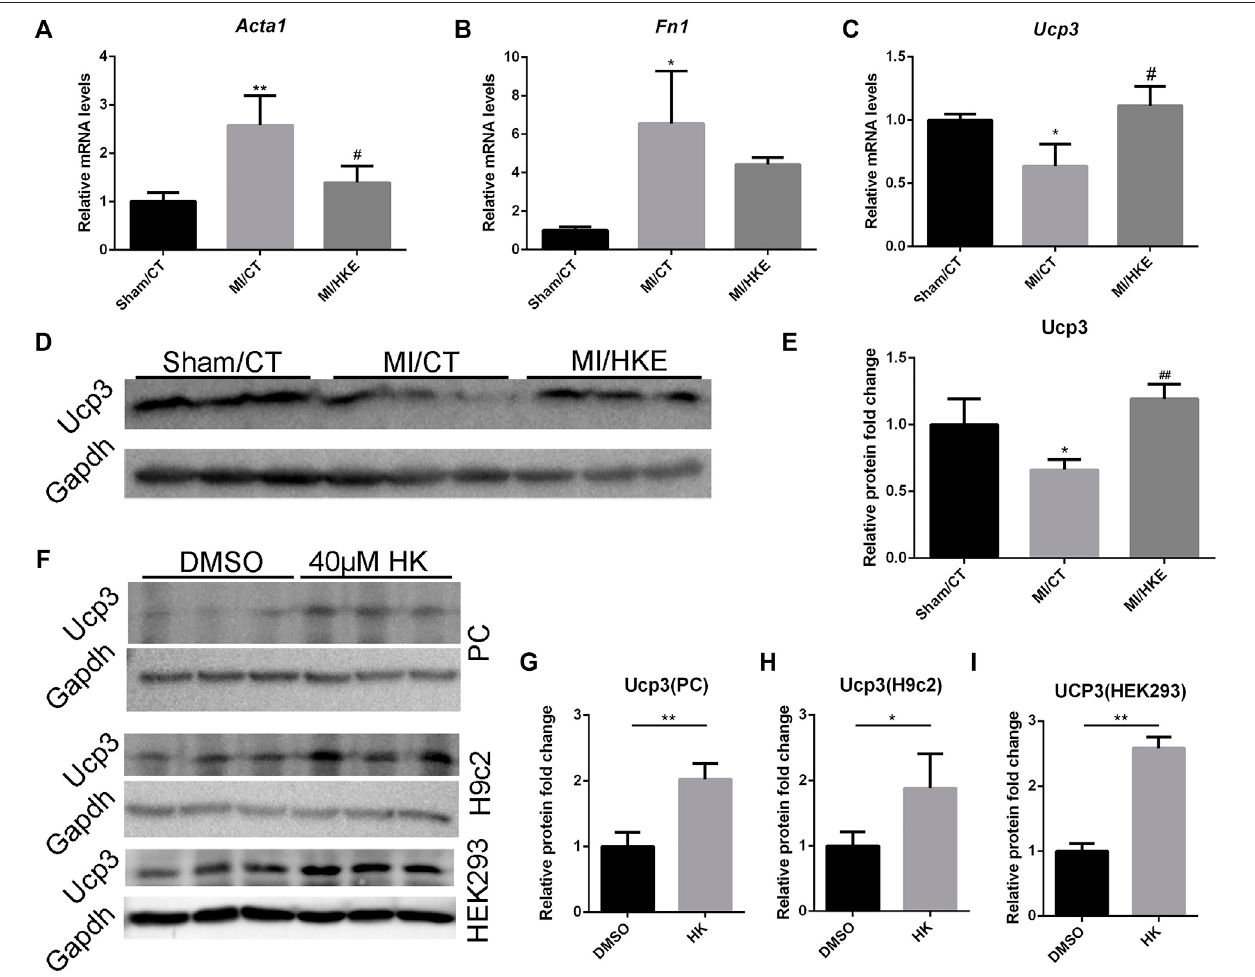
FIGURE5| HKErestores fi brosis-relatedgenesandUcp3.ThemRNAexpression of Acta1,Fn1 ,and Ucp3 inmyocardialtissuewasdetectedusingreal-timePCR ( n = 3 per group). 2 - △△ Ct method was used to analyze relative gene expression levels (A – C) . The Ucp3 abundance in myocardial tissue were detected by Western blot. Gapdh was included as a loading control ( n = 3 per group) (D,E) . After treatment with 40 μ M HK or equal volume of DMSO for 24 h, The Ucp3 abundance in primary cardiomyocytes (PC), H9c2 and HEK293 were detected by Western blot. Gapdh was included as a loading control ( n = 3 per group) (F – I) . Values are shown as means ± SD, *p < 0.05, **p < 0.01 vs. Sham/CT or DMSO, # p < 0.05, ## p < 0.01 vs. MI/CT